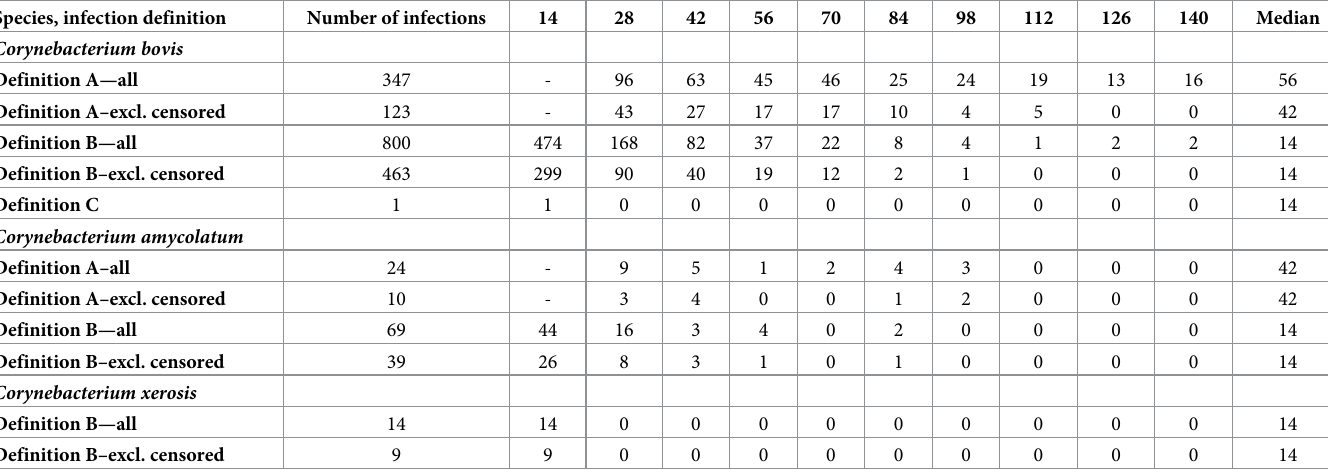
Table 3. Frequency of infections and infection durations of Corynebacterium bovis , Corynebacterium amycolatum and Corynebacterium xerosis . Species, infection